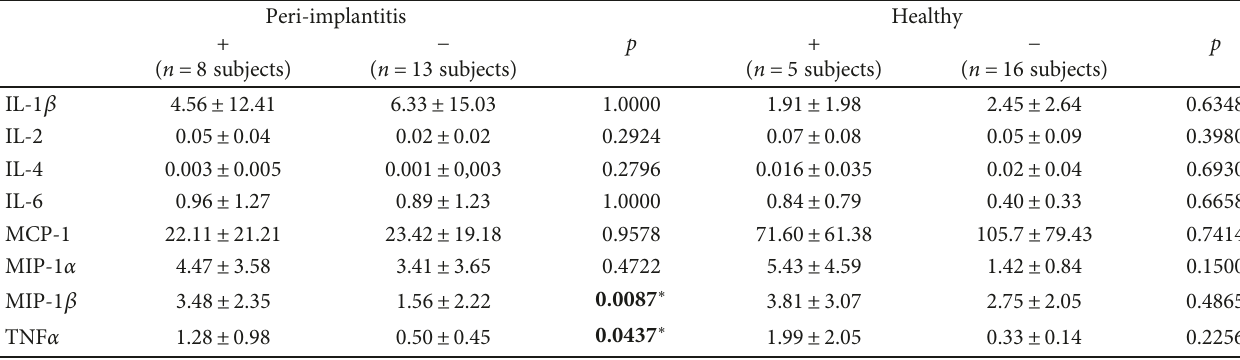
Table 5: Comparison of viral frequency (positive + or negative − ) between subjects with and without peri-implantitis. Student ’ s t -test and Mann – Whitney test ( p > 0 05 ).